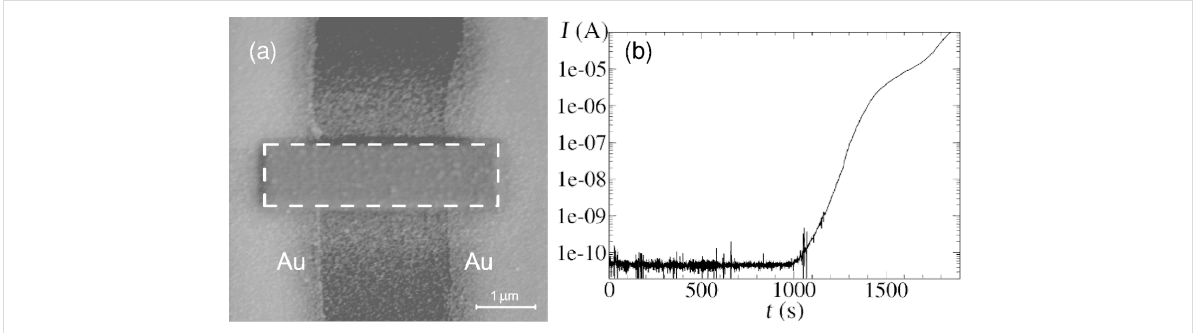
Figure 3: (a) SEM micrograph of Co deposit formed after electron pre-irradiation of the rectangular area depicted by the dashed contour. (b) Time- dependence of the current flow between the Au electrodes at fixed bias voltage (10 mV) as the Co deposit forms spontaneously. The current increase after closing the valve of the gas injector (1200 s) indicates that residual precursor molecules in the SEM vacuum chamber are continuously dissoci- ated resulting in a further increase of the thickness of the Co layer. After exposure of the sample to air the layer thickness was determined by atomic force microscopy and found to be approximately 50 nm.